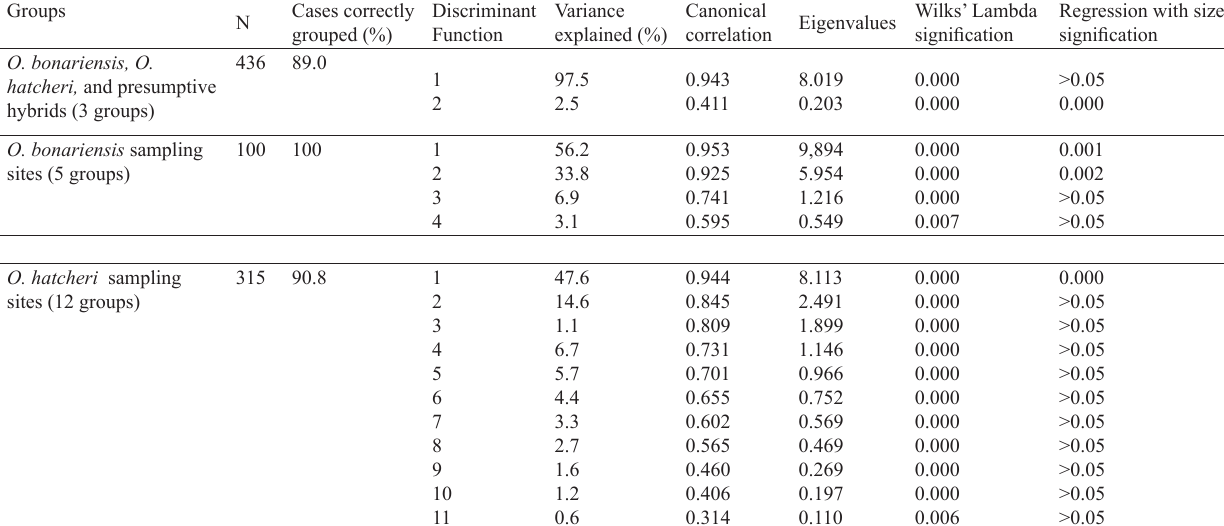
Fig. 5. Morphometric differences between species. DF1 and residual DF2 (of the regression of DF2 versus Standard length) vs. Standard length (SL). Odontesthes bonariensis (white circle) , O. hatcheri (black circle), and presumptive hybrids (gray circle). Table 4. Discriminant Analyses results for two species of Odontesthes